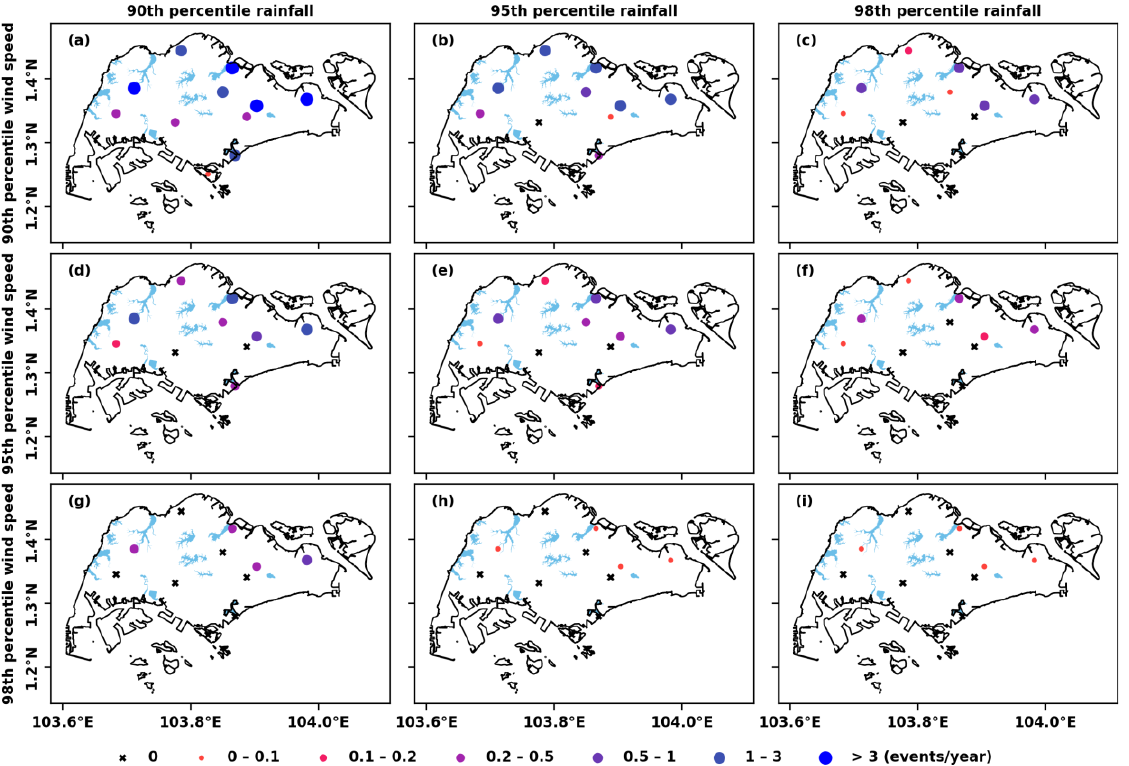
Figure 3. Frequency (events/year) of concurrent 3-hour rainfall and wind speed extremes across Singapore. Rows represent 3-hour mean wind speed thresholds (90th, 95th, and 98th percentiles). Columns represent 3-hour rainfall total thresholds (90th, 95th, and 98th percentiles).